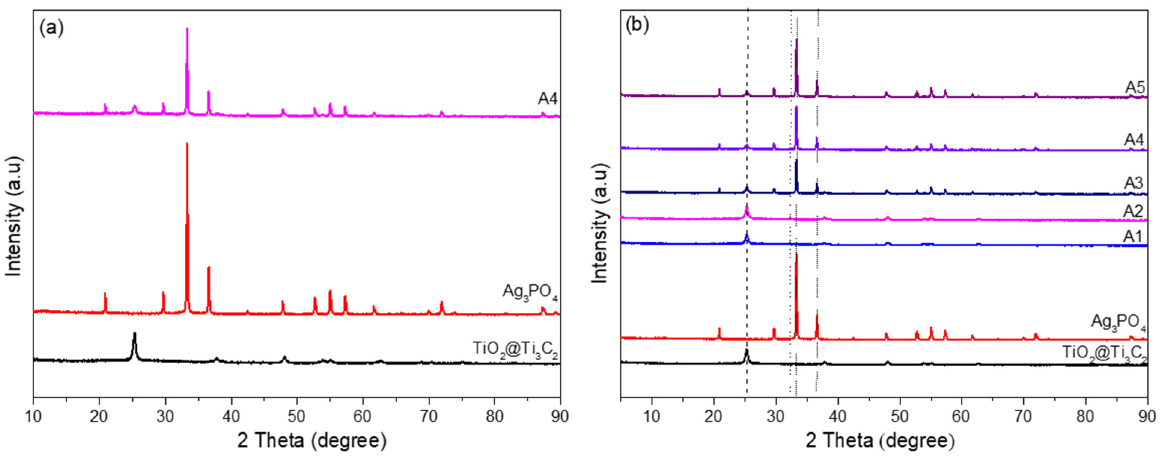
Figure 1. XRD patterns of as-prepared samples: ( a ) TiO 2 @Ti 3 C 2 , Ag 3 PO 4 , and optimized A4 sample. ( b ) Additional XRD patterns of A1, A2, A3, and A5 samples, including A4.